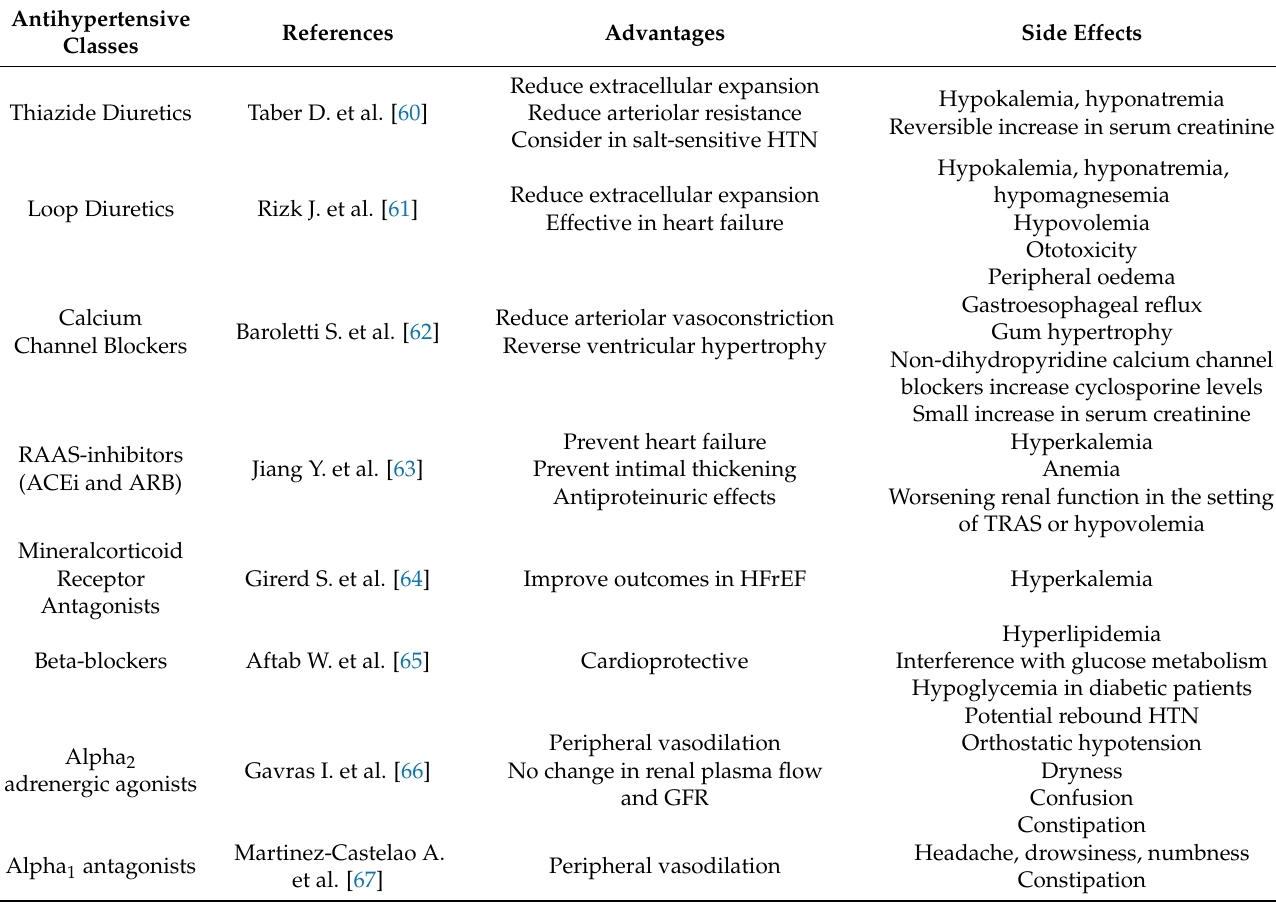
Table 1. Main advantages and side effects of the drugs used in the treatment of hypertension in renal transplant